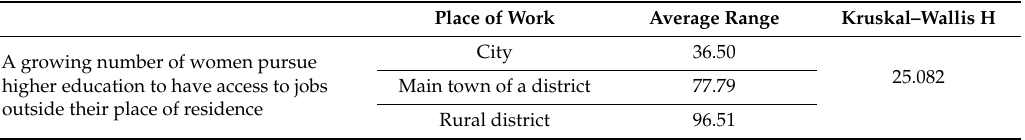
Table 4. Results of the non-parametric Kruskal–Wallis H test for k independent